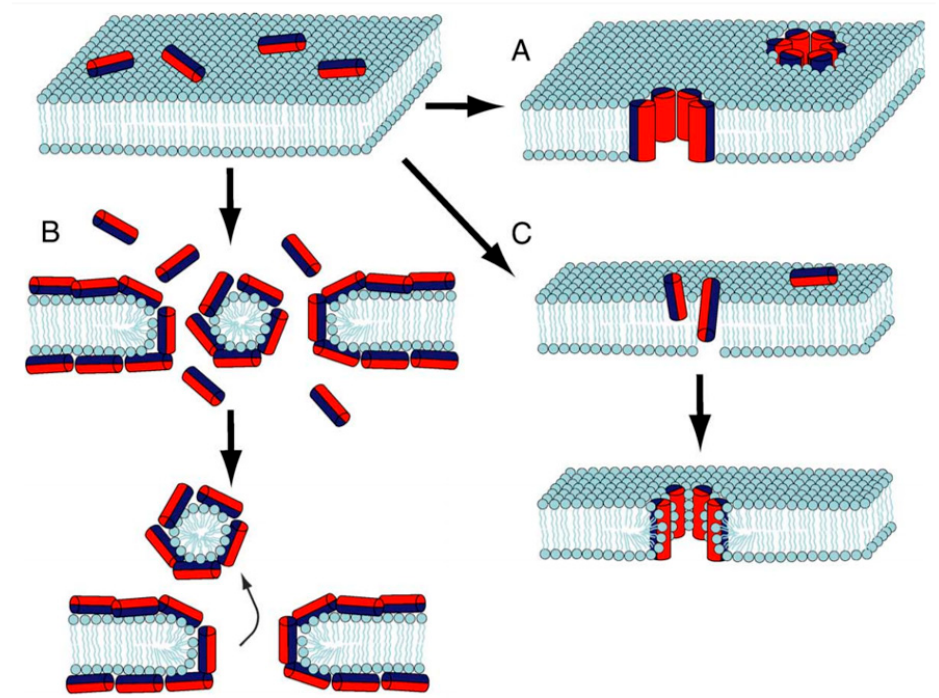
Figure 3. Antimicrobial peptide mechanisms of action. ( A ). The barrel-stave model. ( B ) The carpet model. ( C ) The toroidal or wormhole pore model. Adapted from [48]. Copyright © 2012 Elsevier Ltd. All rights reserved.